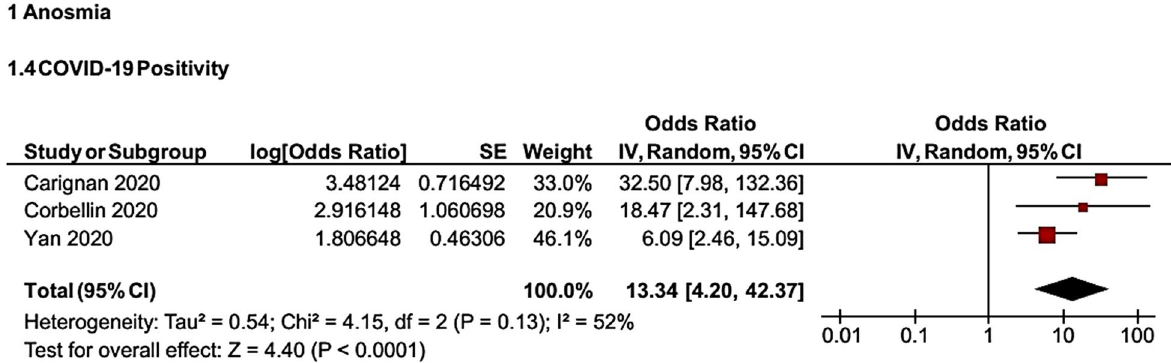
Fig. 4 Forest plot for the association of OD with PCR test positivity in